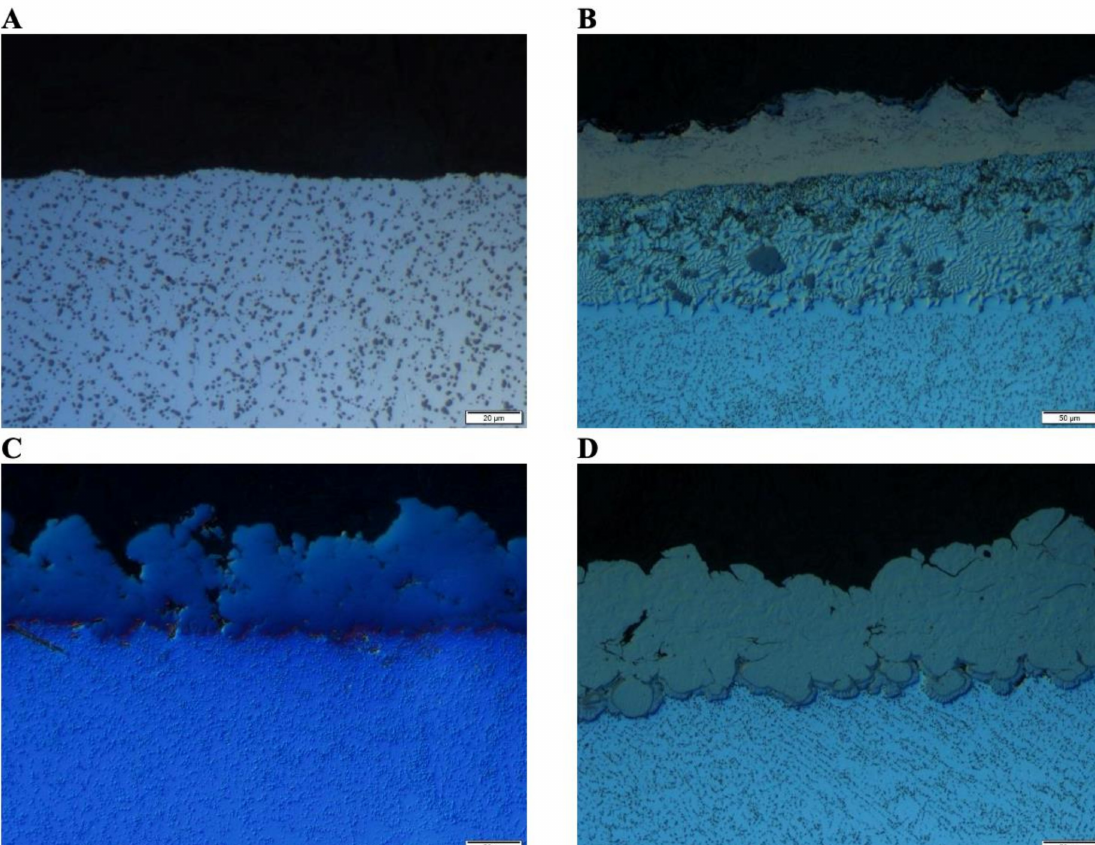
Figure 5. ( a ) Optical micrograph of the A365 HPDC system in the T6 condition. ( B ) Optical micrograph of the copper CGDS processed A365 HPDC system in the T6 condition. ( C ) Optical micrograph of the titanium CGDS processed A365 HPDC system in the T6 condition. ( D ) Optical micrograph of the nickel CGDS processed A365 HPDC system in the T6 condition. Black portions within the micrographs capture the mounting material. The scale bar embedded within each micrograph presented represents 50 µ